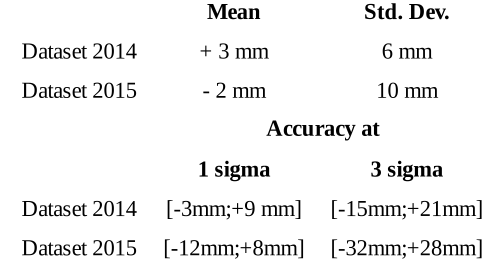
Table 4: Indicators qualifying the accuracy of both datasets accuracies.